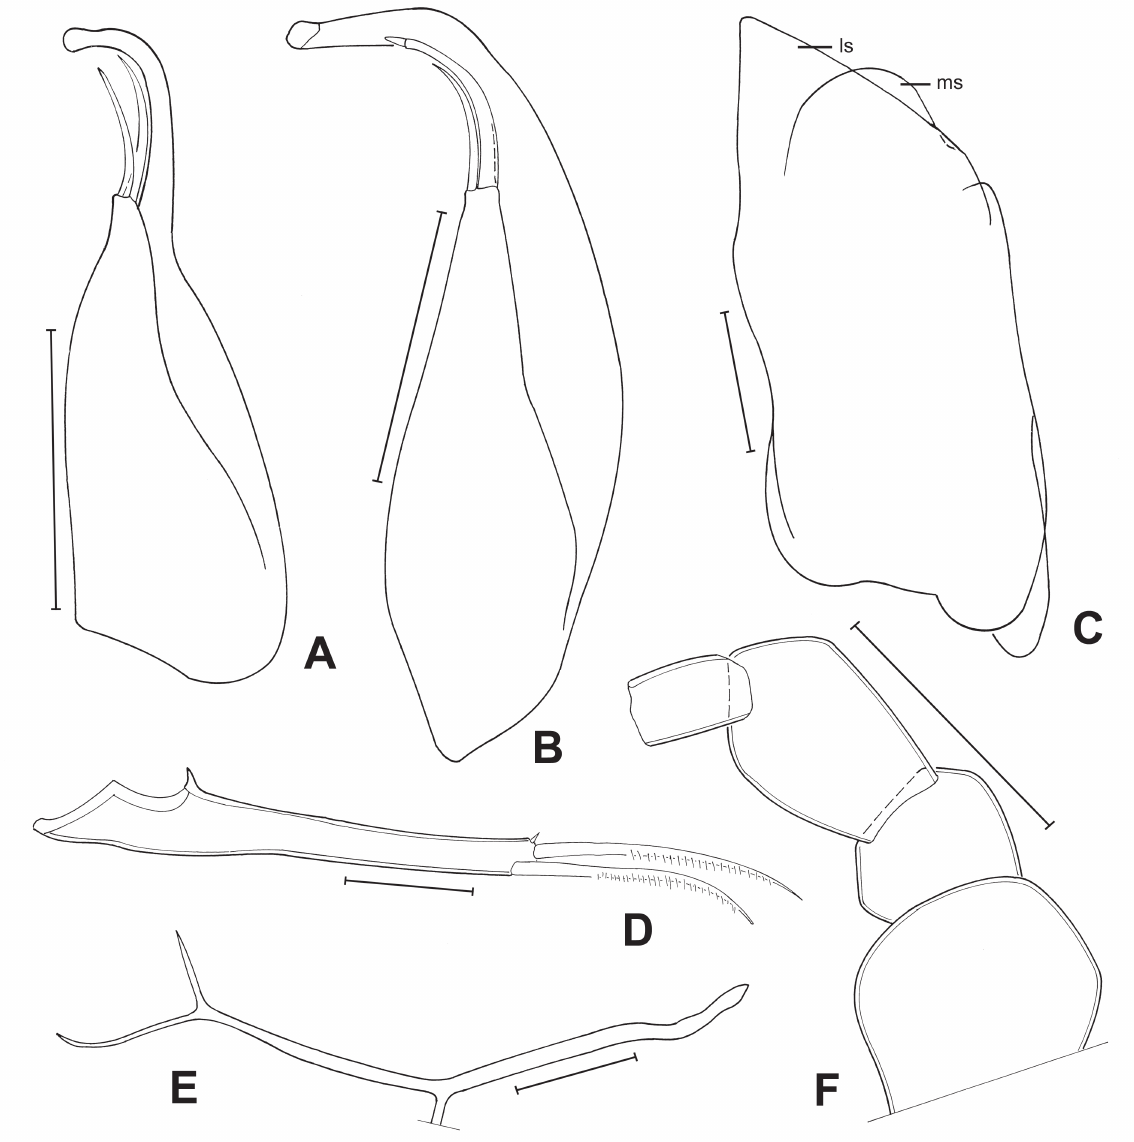
Fig. 13. Limbs of Candobrasilopsis acutis sp. nov. (♂). A . Right prehensile palp (MZUSP 32703). B . Left prehensile palp (MZUSP 32703). C . Hemipenis (MZUSP 32703). D . Caudal ramus (MZUSP 32703). E . Attachment of the caudal ramus (MZUSP 32703). F . Md palp (MZUSP 32703). Scale bars: A–F = 50 µ